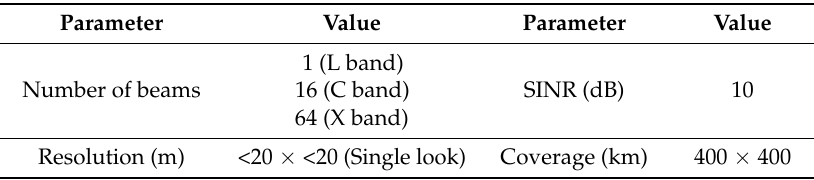
Table 3. Performance of GEO SAR